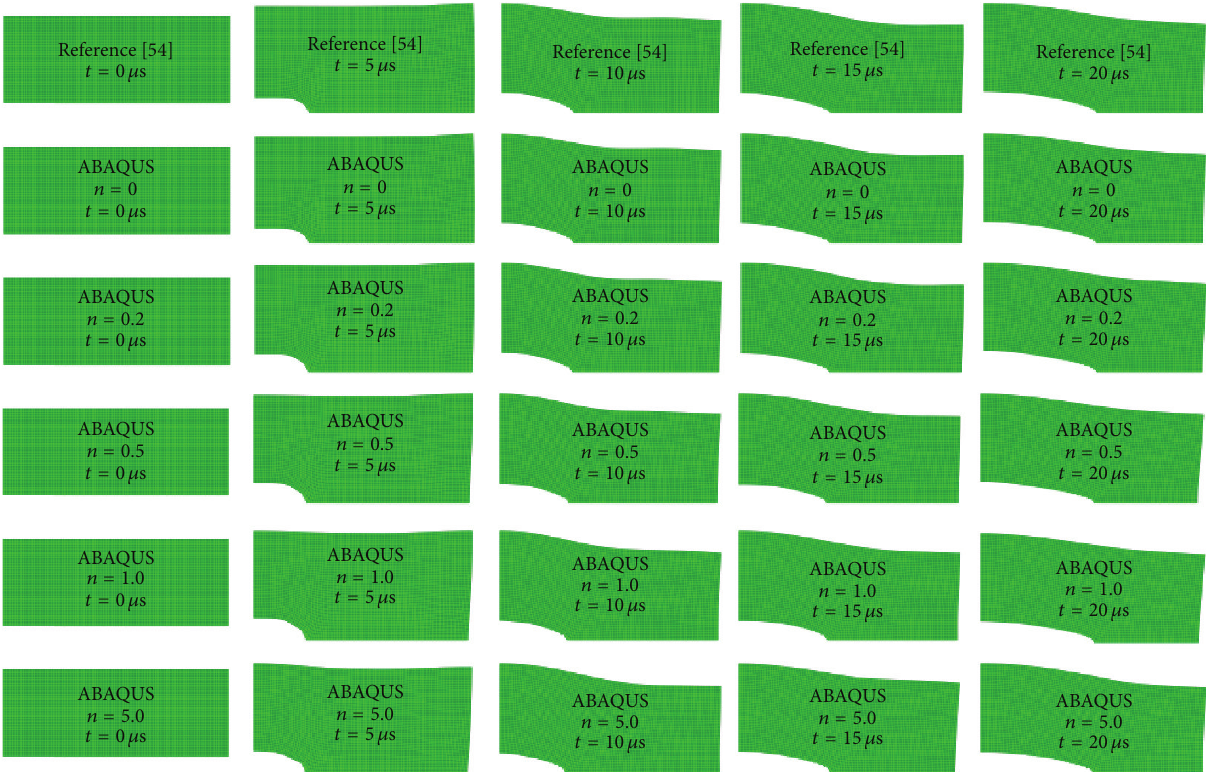
Figure 13: Deformed body for dynamic crack propagation at different crack length ( 𝐶 = 1000 m/s).